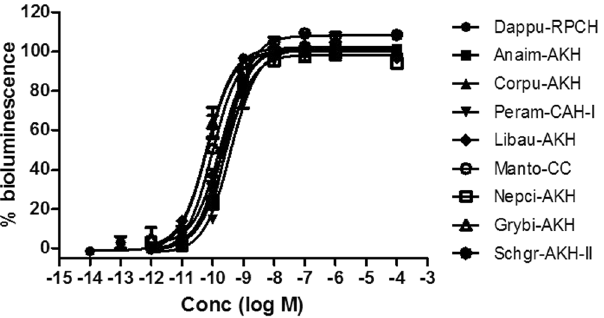
Figure 5. Dose-response curves of Dappu-RPCH and structurally related insect AKH peptides tested on Dappu-RPCHR expressing cells in an in vitro bioluminescent assay. Data shown as Mean ± SD, each experiment was performed in triplicate, and % bioluminescence is a proxy for receptor activation. Table 1 shows peptide structure and EC 50 values.